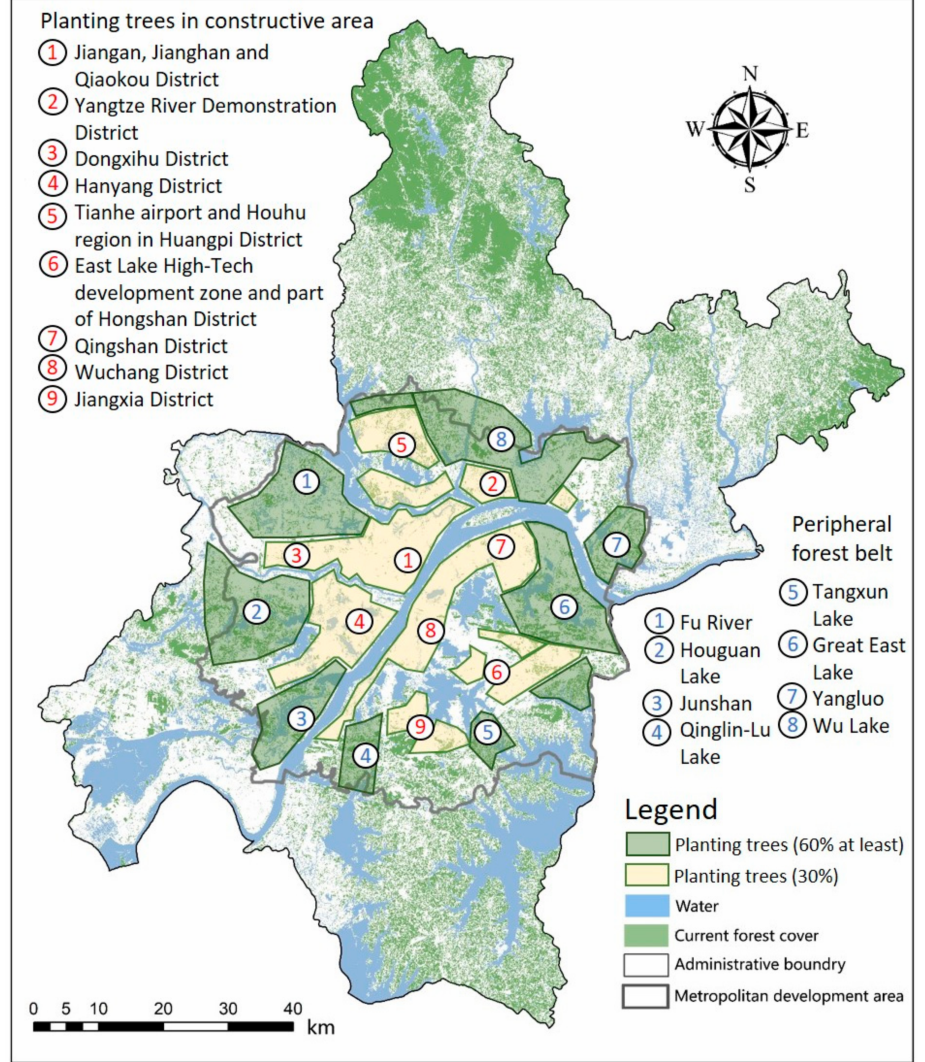
Figure 6. A ff orestation spatial pattern for PM 2.5 removal in Wuhan